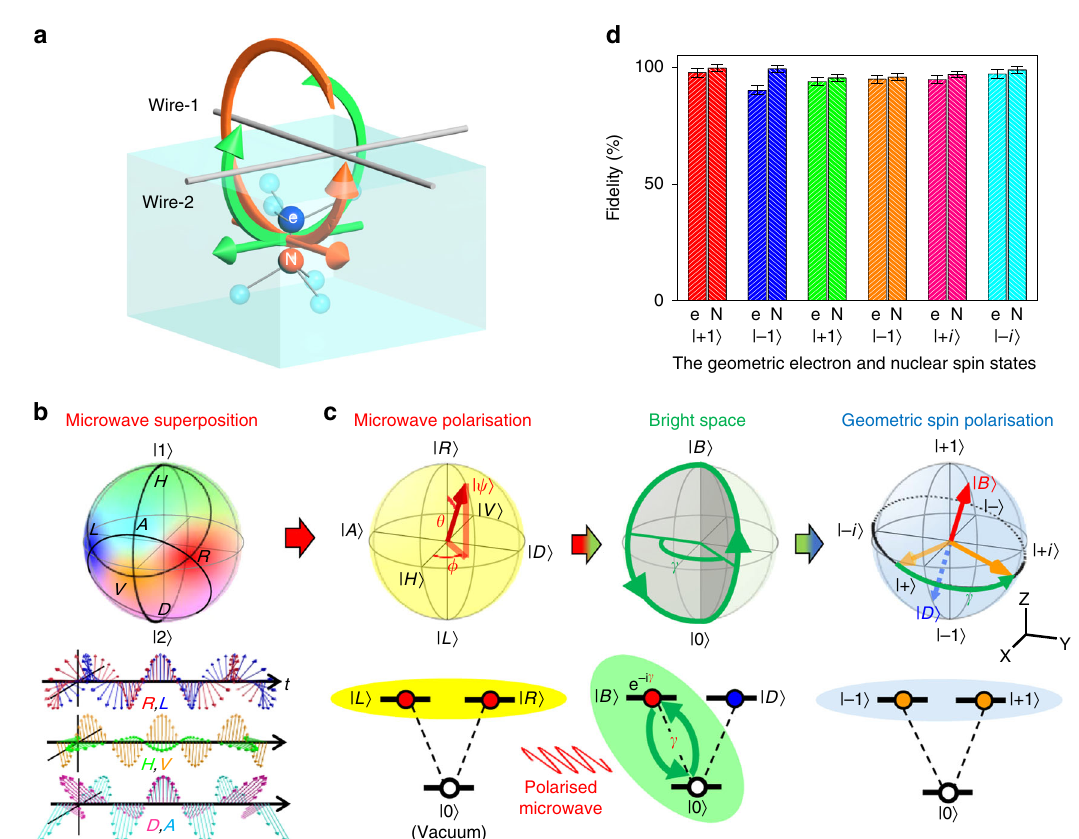
Fig. 1 Polarisation-based holonomic quantum gates. a The con fi guration of the two crossed wires to produce a polarised microwave at the position of an NV centre. b Mapping from the relative amplitude and phase of the microwaves generated by the two crossed wires into the polarisations effective for the electron or nitrogen ( 14 N) nuclear spin in an NV centre under a realistic con fi guration (Methods). The |1 〉 and |2 〉 represent microwaves generated from, respectively, wires 1 and 2. c The mechanism underlying the holonomic quantum gate. The polarised microwave induces a cyclic evolution of the geometric spin in the bright space based on the bright state | B 〉 and the ancillary state |0 〉 with a solid angle 2 γ to induce a geometric phase γ on | B 〉 , resulting in the rotation of the geometric spin around an axis de fi ned by | B 〉 and the unchanged dark state | D 〉 . d The fi delities of the state preparation and measurement for the geometric electron (e) and nitrogen nuclear (N) spin. Error bars are de fi ned as the s.d. of the photon shot